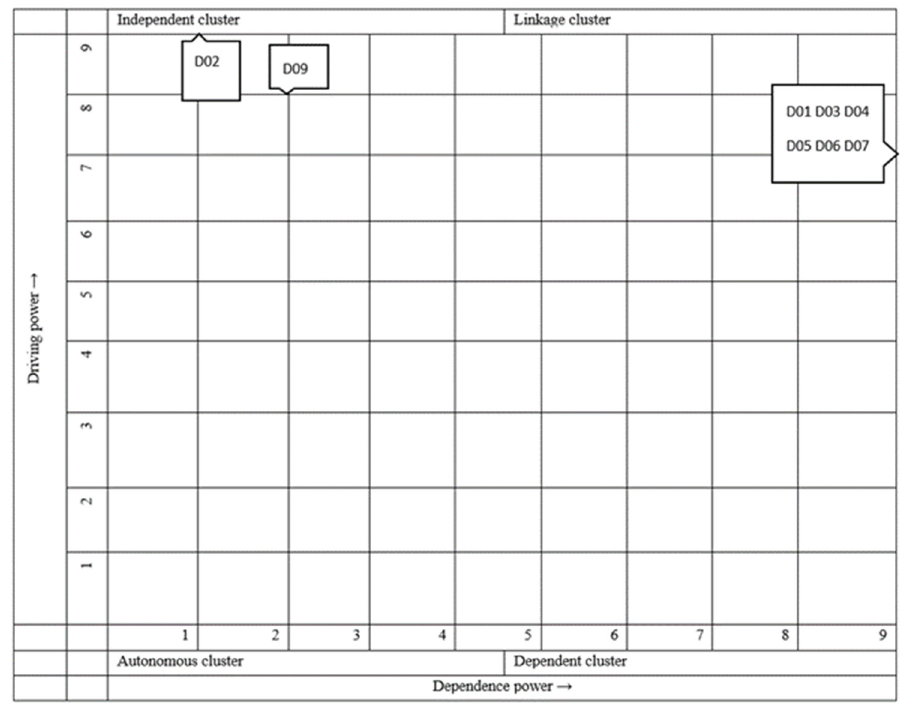
Figure 3. MICMAC